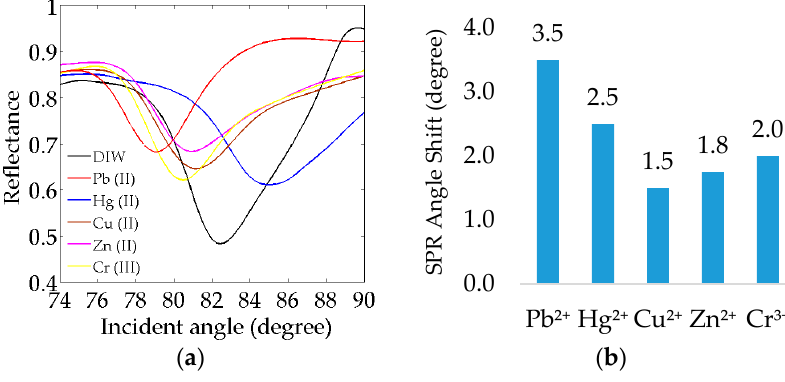
Figure 9. ( a ) SPR reflectivity and ( b ) Shift in SPR angle of the Au/Ag/Au/CS–GO SPR sensor in 1 ppm of Pb 2+ , Hg 2+ , Cu 2+ , Zn 2+ and Cr 3+ .